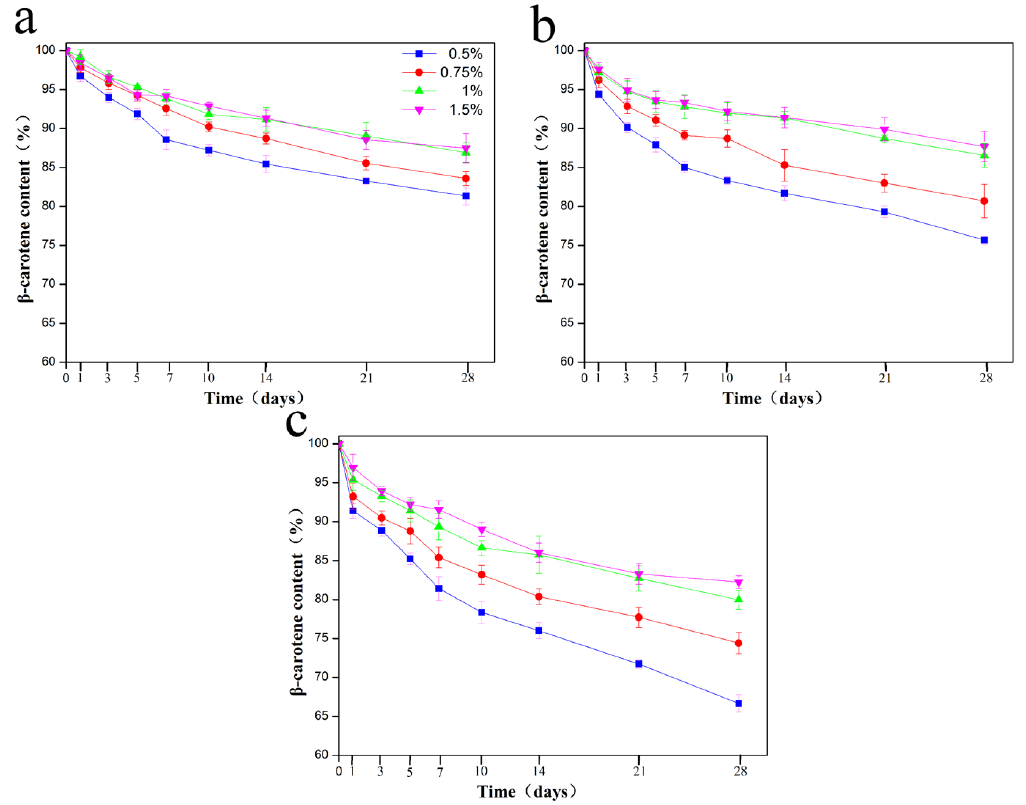
Figure 5. Effect of the concentration of GNPs Pickering emulgels on the β-carotene storage stability at ( a ) 4 ◦ C, ( b ) 25 ◦ C, and ( c ) 55 ◦ C for 28 ( a ) 4 °C, ( b ) 25 °C, and ( c ) 55 °C for 28 days.